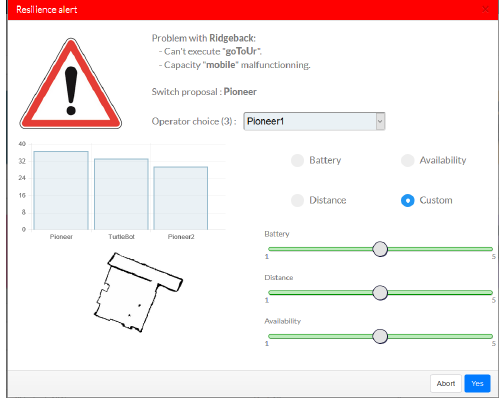
Figure 7. Resilience Graphical User Interface (GUI).